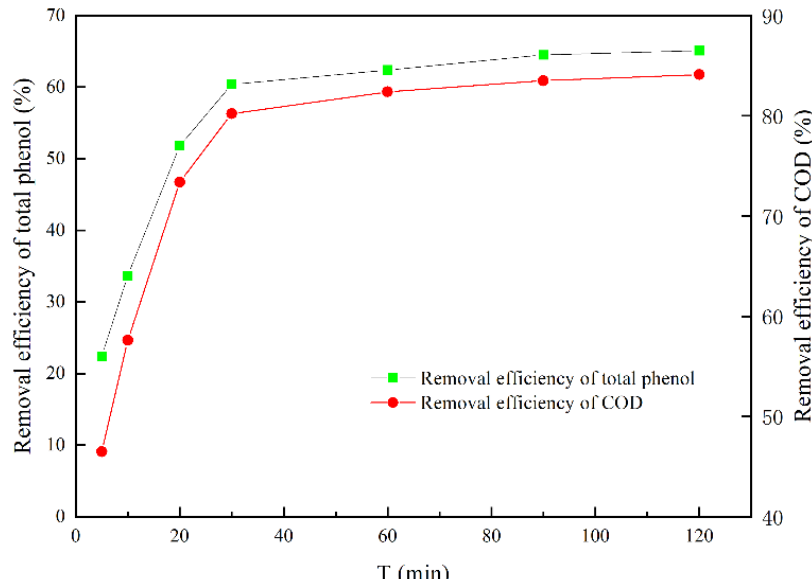
Figure 8. Effects of reaction time on removal efficiency of total phenol and COD.